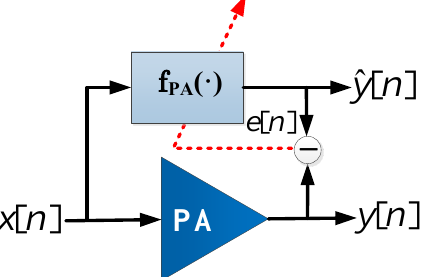
Figure 1. Block diagram of power amplifier (PA) behavioral